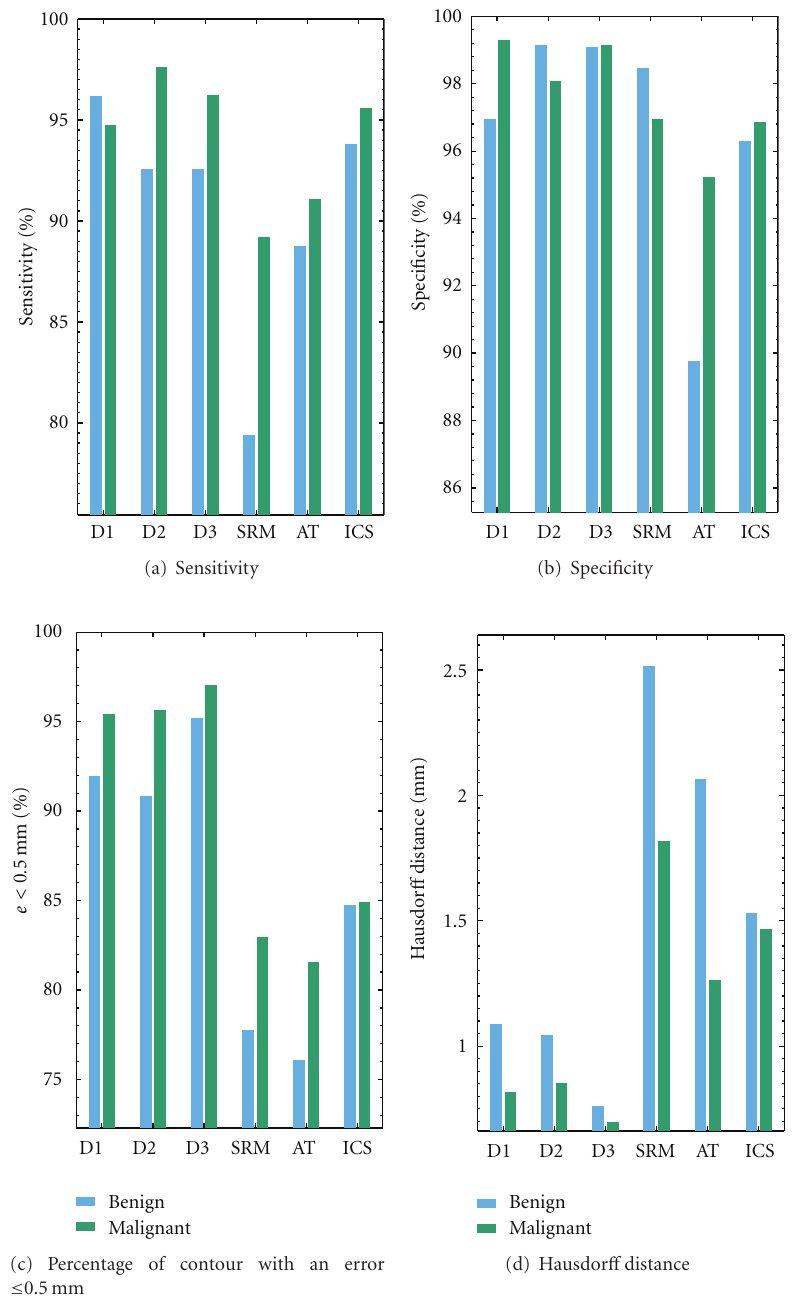
Figure 6: Average values of the accuracy of segmentations, quantified by the four distinct border measures, showing the performance of the proposed ICS method against the di ff erent segmentation methods analyzed. The lesions are grouped by histopathological diagnosis. The mask generate by majority voting of the manual segmentation of the three dermatologists is used as reference. The bars refer to benign (blue) and malignant (green)